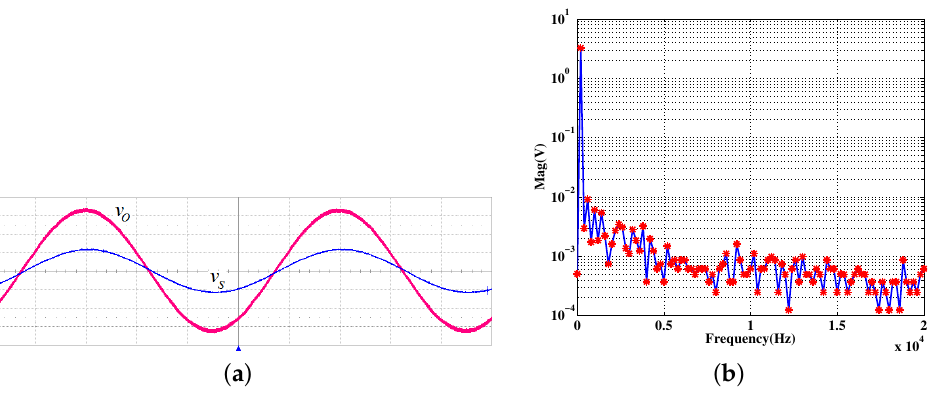
Figure 14. ( a ) v s and v o waveforms at 200 Hz: v o (1 volt/div), v s (0.1 volt/div), timescale: (1 microsec- ond/div) ( b ) frequency spectrum of 200 Hz output voltage.